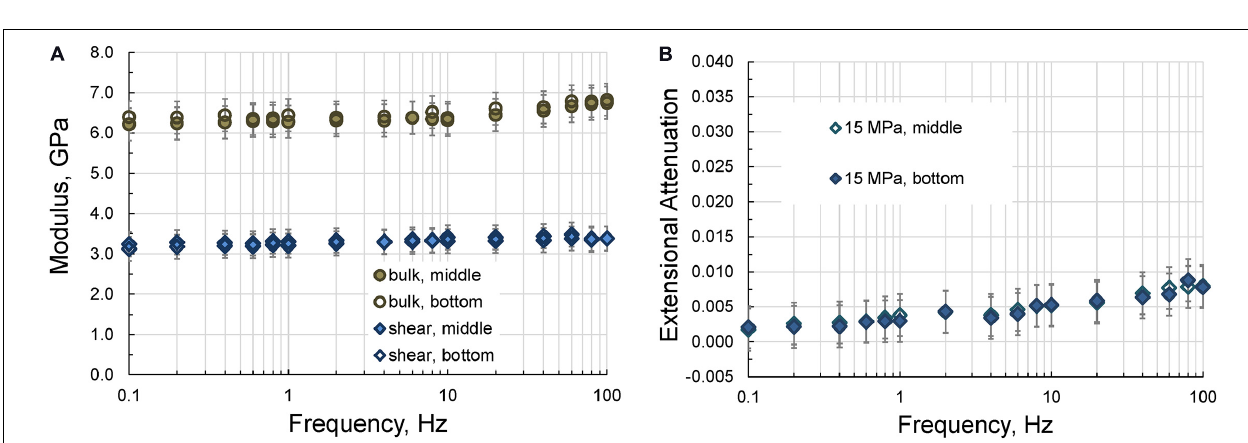
FIGURE 4 | The frequency dependences of the Young’s modulus (A) and Poisson ratio (B) of the acrylic sample measured at a uniaxial of 15 MPa.